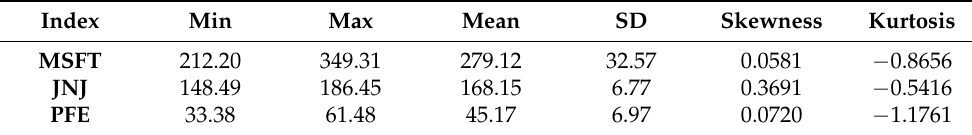
Table 2. Descriptive statistical analysis results of three original stock